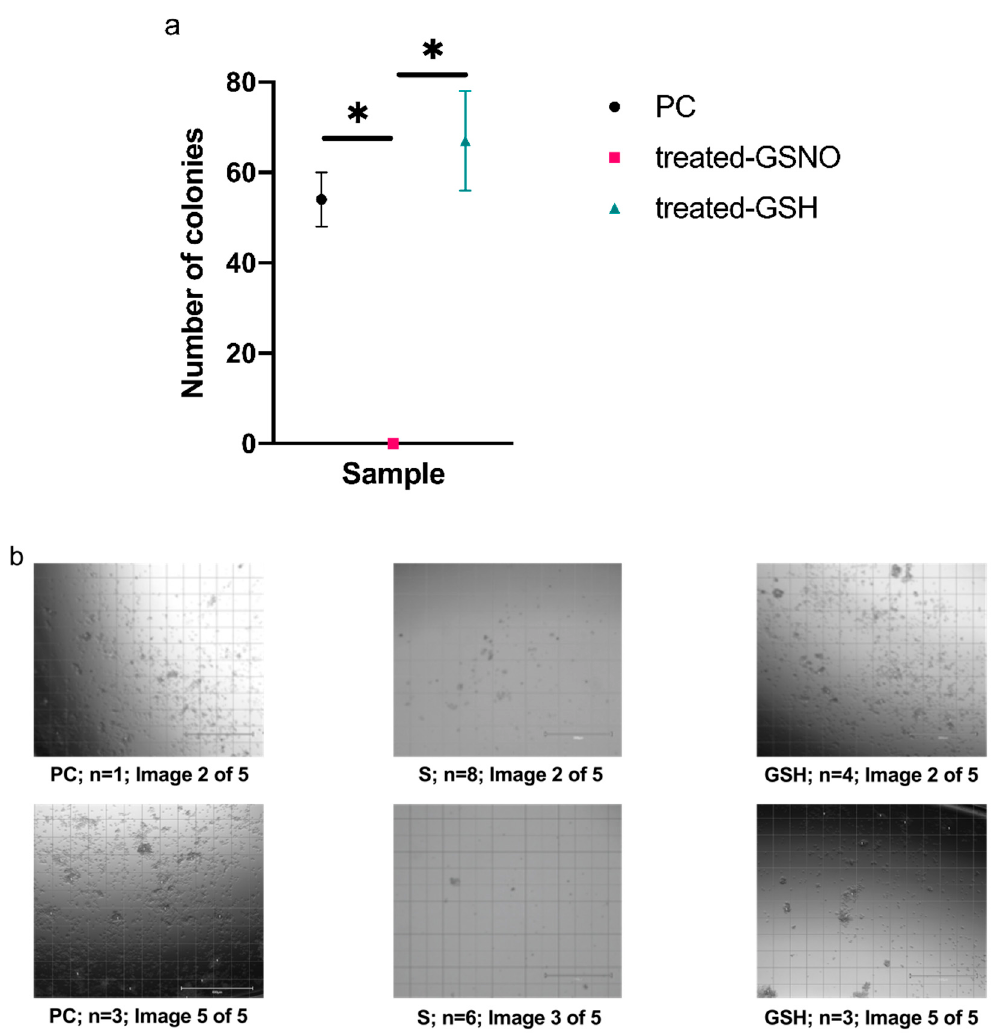
Figure 5. Colony formation capacity of N2a neuroblastoma cells after exposure to 1 mM GSNO for 24 h at 37 ◦ C, 5% CO 2 . ( a ) Data points represent the mean of n ≥ 3 data points ± standard deviation. One-way ANOVA revealed a statistically significant di ff erence between the treated-GSNO sample (0 colonies detected), the PC (54 ± 6), and treated-GSH (67 ± 11) samples while the PC and treated-GSH samples were not statistically di ff erent at a 99% CI. Graphically, statistical significance at the 99% CI was illustrated with * (1 asterisk). ( b ) Representative images of N2a cells after the colony formation period (3 weeks).